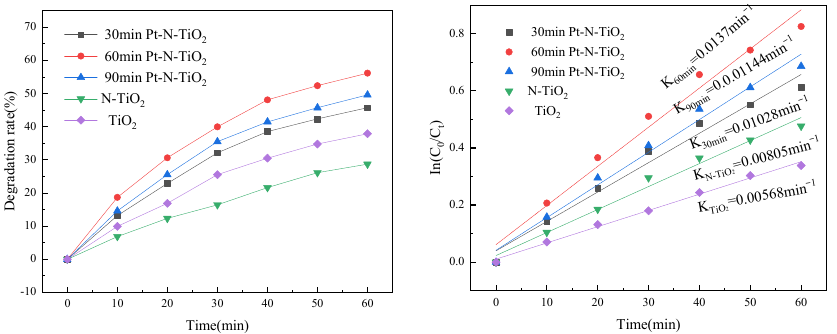
Figure 7. I ‐ t pattern of each nanotube.